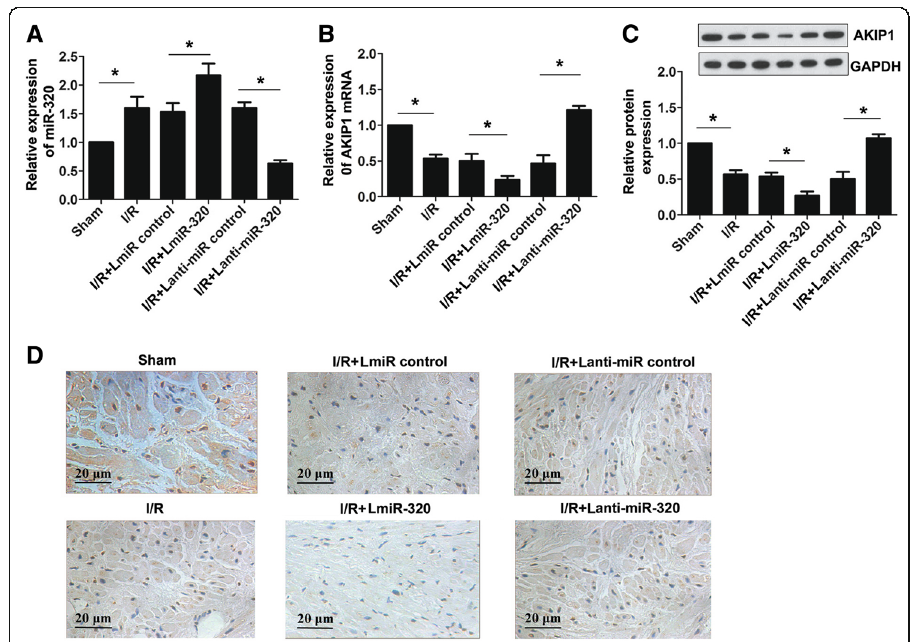
Fig. 4 Expression levels of miR-320 and AKIP1 in myocardial tissue. a , b Relative expression levels of miR- 320 and AKIP1 mRNA were evaluated via qRT-PCR in myocardial tissue. c Relative protein expression of AKIP1 was detected by Western blot. d Immunohistochemistry stain of AKIP1 in myocardial tissue (scale bar = 20 μ m). * P <